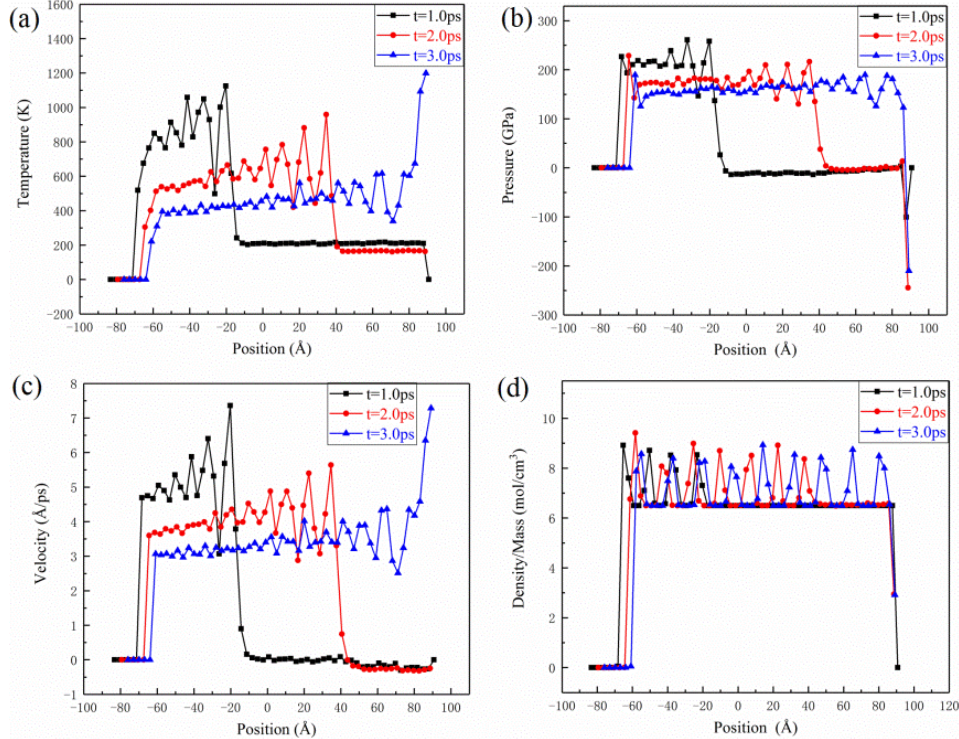
Figure 8. Variation of average value of per atom in all physical quantities during propagation of the shock wave: ( a ) temperature; ( b ) pressure; ( c ) velocity; ( d ) ratio of density to mass.